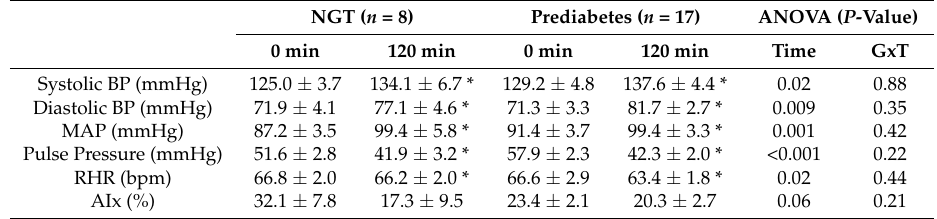
Table 3. Cardiovascular disease (CVD) risk factors in adults with normal glucose tolerance (NGT) and prediabetes. NGT ( n =